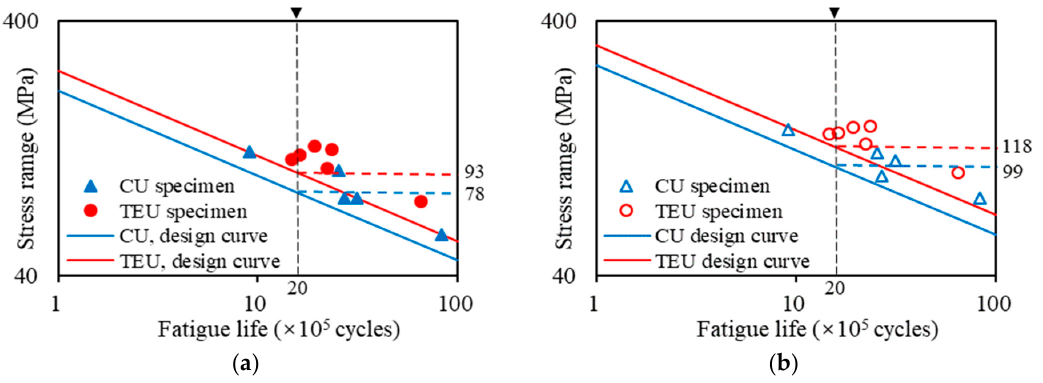
Figure 3. Stress-life data of the fatigue test: ( a ) Nominal stress approach; ( b ) Hot spot stress approach.